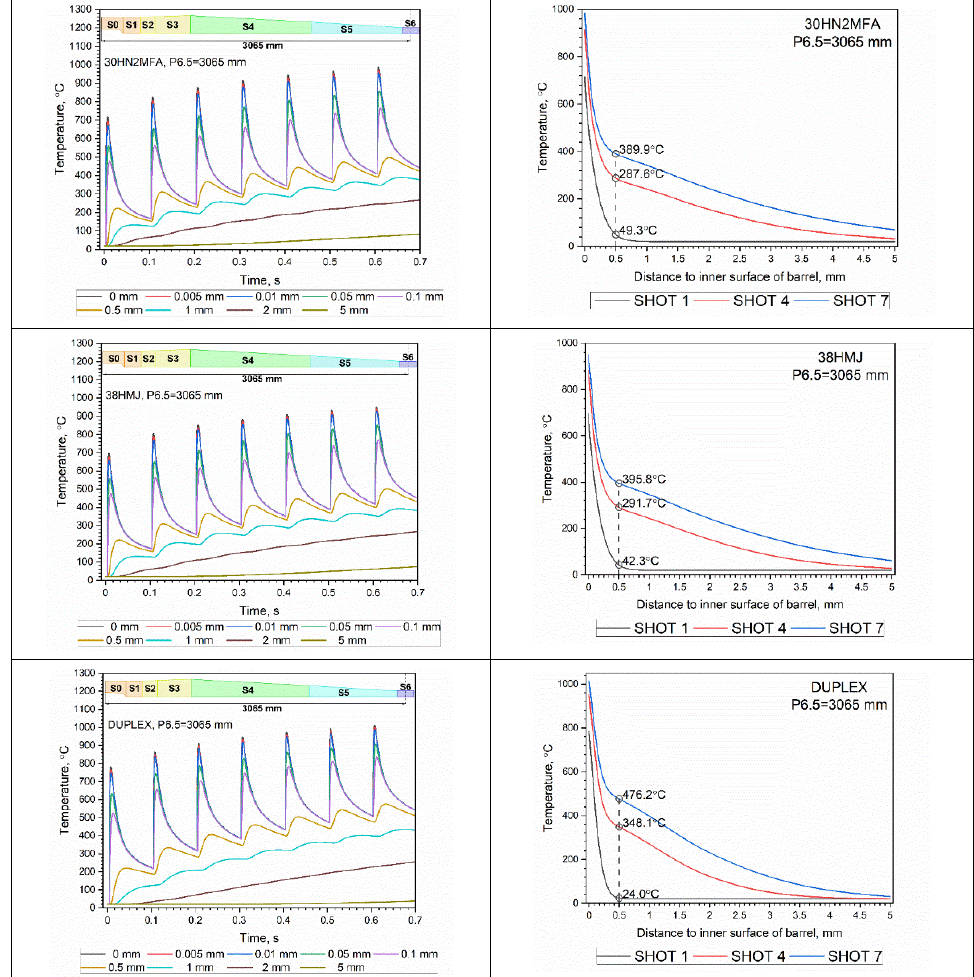
Figure 10. Temperature distribution T i ( t , r , z ) along the barrel thickness for selected steels for a sequence of seven shots: left side— z in the middle of the sixth zone S6 (color-coded for the distance from the inner surface of the barrel); right side—for the first, fourth and seventh shots. The sign: P6.5—in the middle of the S6 zone.